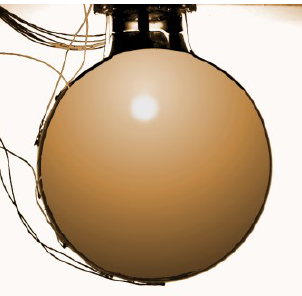
Fig. 16. Photograph of the initial stage of the experiment. The scaled-up model of the single spherical capsule, filled to the top with n -eicosane , was opaque in the solid state (while transparent when molten). Thus the solid phase fraction could be evaluated from the photographs. As the shell was used a glass vessel obtained from manufacturer of laboratory glass components. The thin wires visible at left are leads to eight resistor-type thermometer